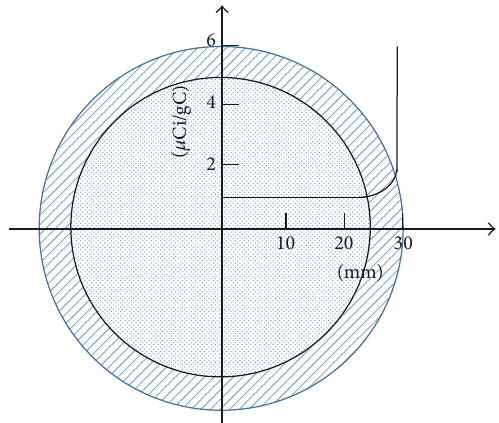
Figure 1: C-14 profile in a spent AVR